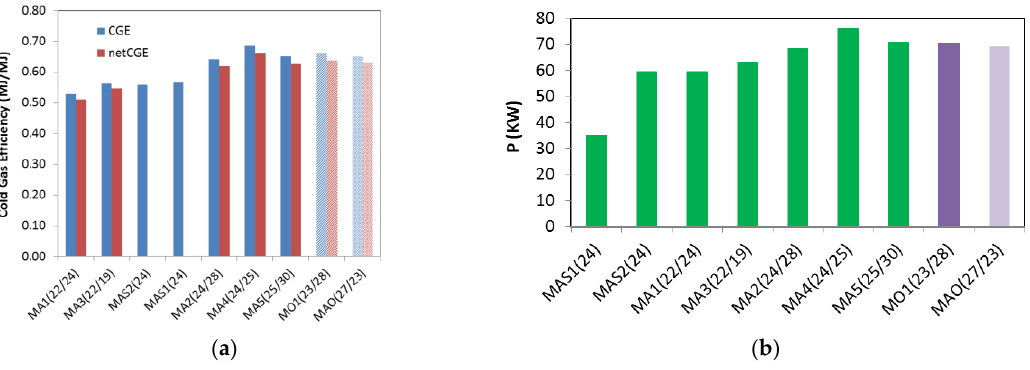
Figure 13. Gasification of almond shells (M): ( a ) Efficiency of energy conversion in the gasification; ( b ) Thermal power of the plant.